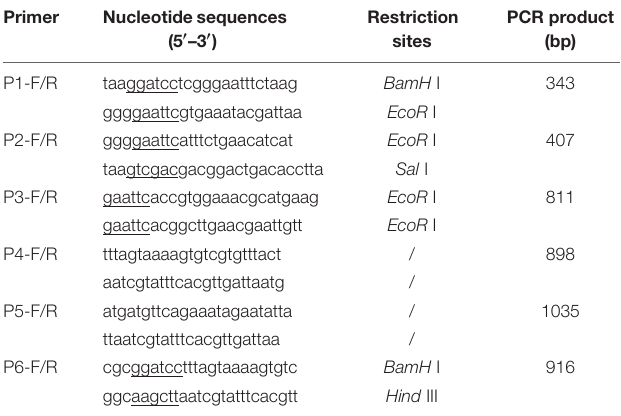
TABLE 2 | Primers used in this study. Primer Nucleotidesequences (5 (cid:48) –3 (cid:48) )